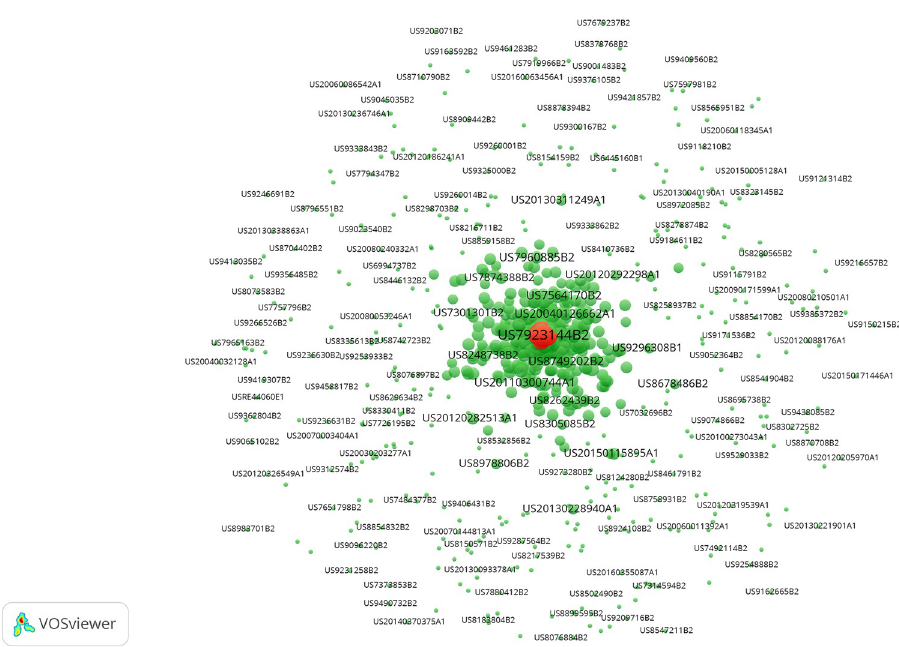
Fig 3. The citation-base map of the EV patents. The highly cited in 3 years are marked in red, and the non-highly cited ones are marked in green.